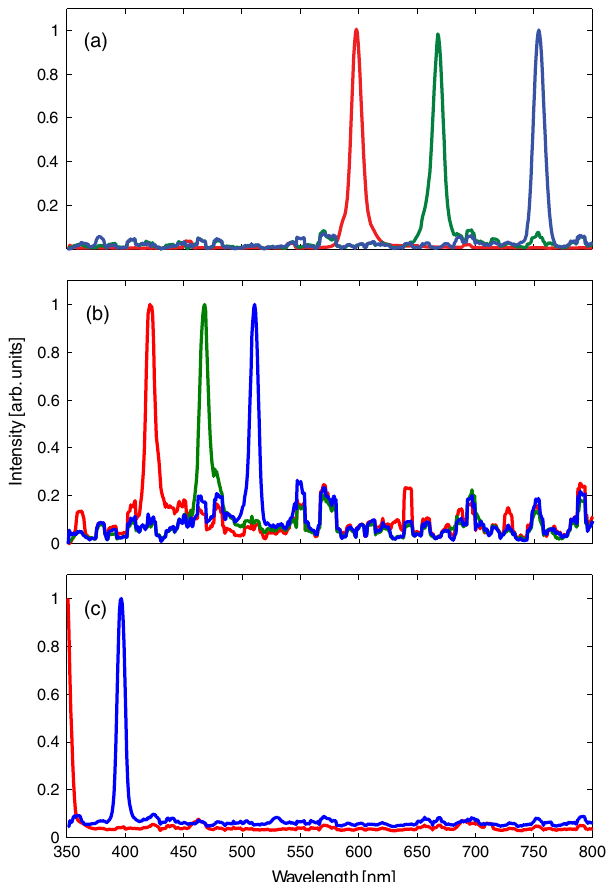
FIG. 2. Typical spectrums of FEL radiation during tuning: (a) second harmonic of the seed laser, (b) third harmonic of the seed laser, and (c) fourth harmonic of the seed